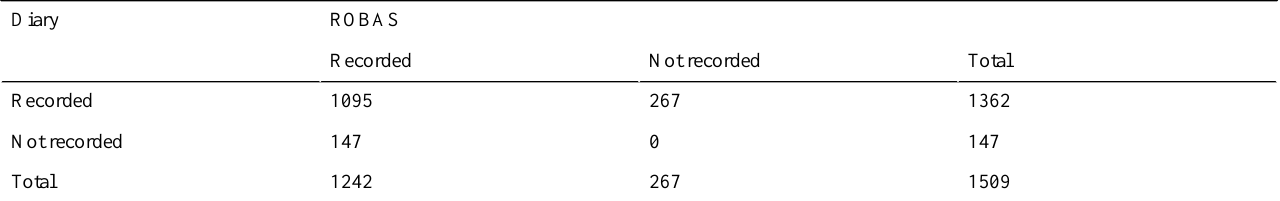
Table 2. Brushing session counts according to ROBAS and diaries.